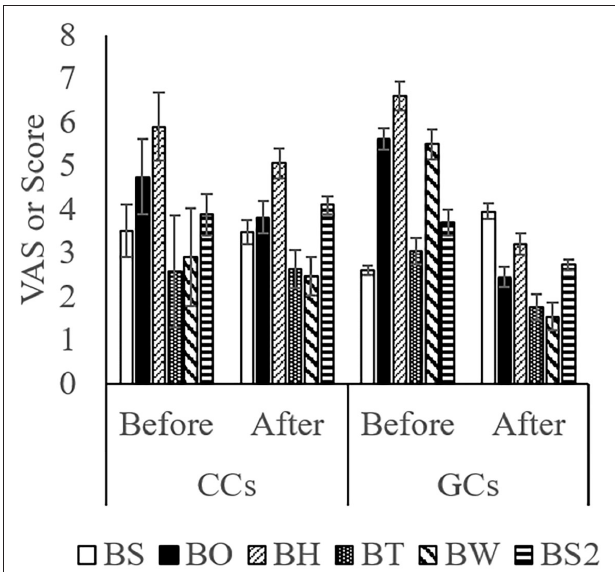
FIGURE 4 | Temperament traits while moving to the stock for blood sampling, while in the device, and during blood sampling in GCs and CCs. The horizontal axis shows the temperament before and after the start of grazing. Data are presented as the means ± SEM. BS, The score for resistance while moving to the stock for blood sampling; BH, The visual analog scale (VAS) score for head movement; BT, The VAS score for tail flicking; BW, The VAS score for walking/stepping; BO, The VAS score for overall movement; BS2, The score for resistance during blood sampling.